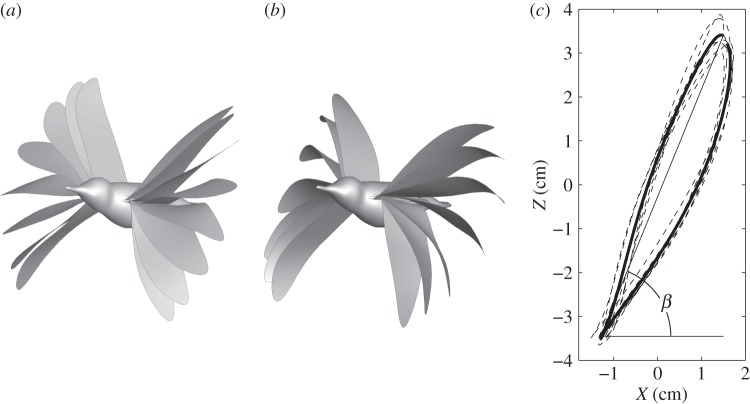
Reconstructed wing position of the hummingbird within one beat cycle: (a) downstroke, (b) upstroke and (c) the left wingtip trajectory as viewed in a body-fixed coordinate system, where the thick line is the phase-averaged and the thin dashed line is the instantaneous data.